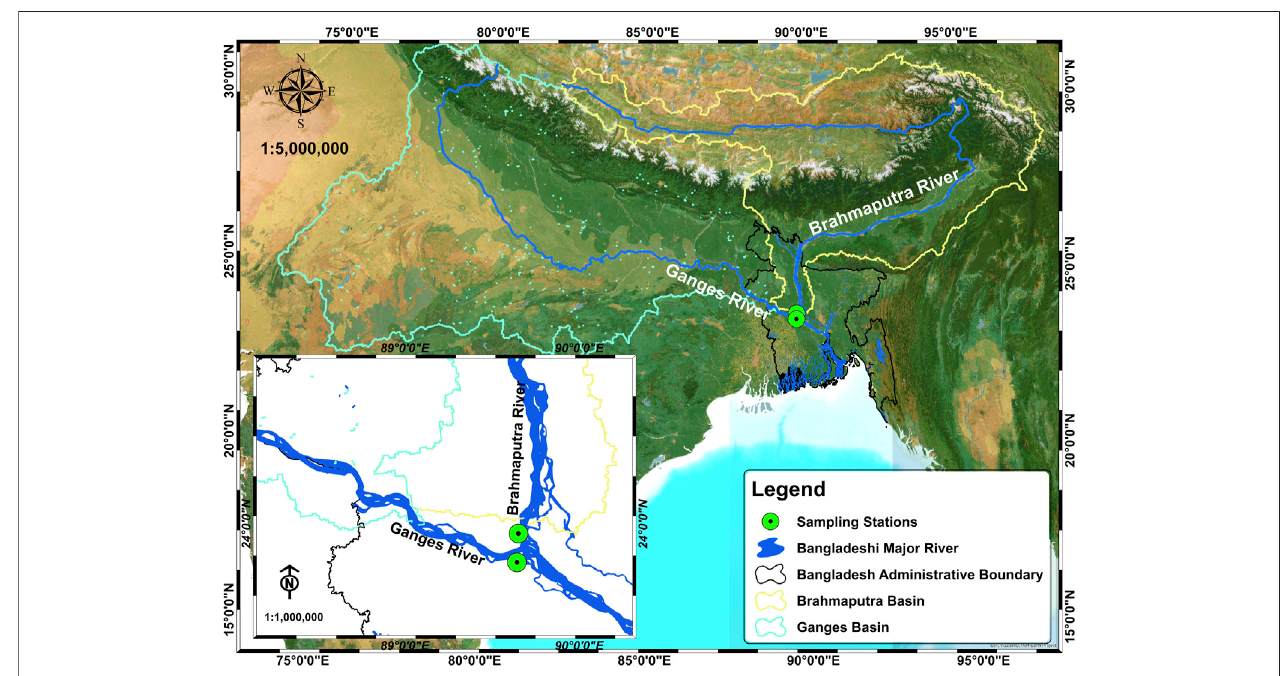
FIGURE1| MapofthestudyareasandmonitoringstationsattheGangesandBrahmaputrarivers.ThemapwascreatedusingArcGIS10.3.1andthetopographic image modi fi ed from ArcGIS/ESRI online.